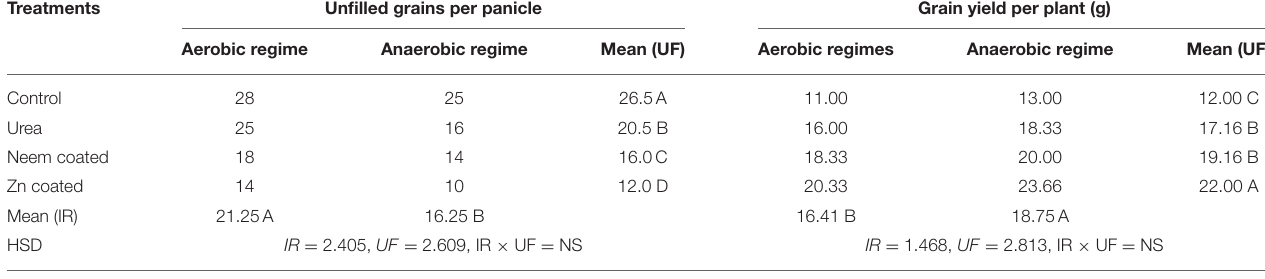
TABLE 3 | Impact of conventional urea, neem-coated urea, and zinc-coated urea on a number of unfilled grains per panicle, grain yield per plant, total biomass per plant, and harvest index of rice plant grown in aerobic and anaerobic regimes. Treatments Unfilled grains per panicle Grain yield per plant (g) Aerobic regime Anaerobic regime Mean